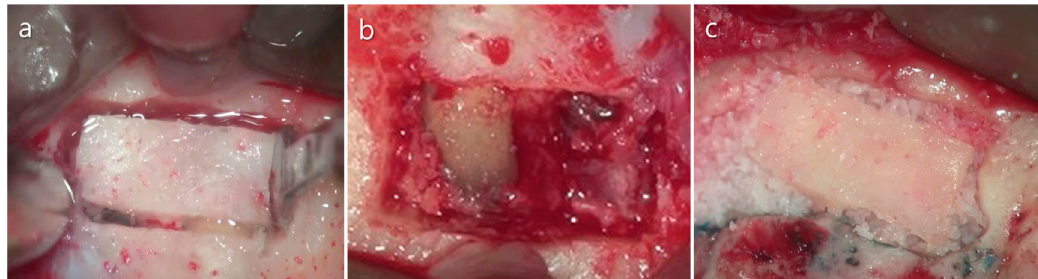
Figure 12. The “bony window technique” with a piezoelectric saw. ( a ) Bone preparation for the cortical window. ( b ) Uncovered area of the lesion and the apices of the roots. ( c ) Allogenic bone was grafted and cortical bone was repositioned. Images were modified from Kim et al. [40] after receiving permission from the journal.